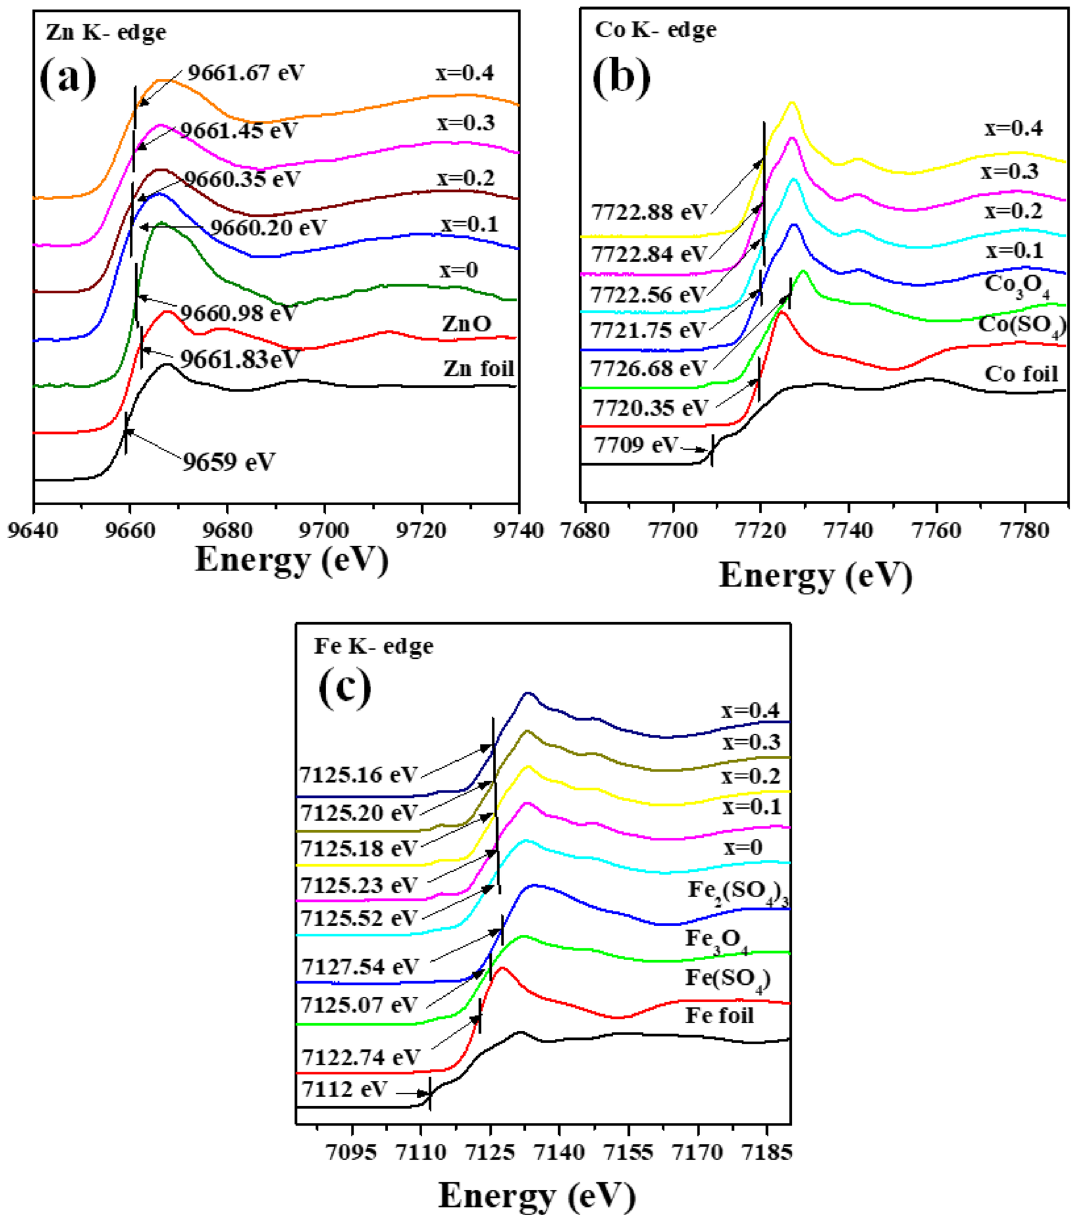
Figure 8. ( a ) Zn, ( b ) Co and ( c ) Fe K-edge XANES spectra of various standard materials and Co x Zn 1−x Fe 2 O 4 (x = 0.0–0.4) resistance (Rct), constant phase element (CPE) and Warburg resistance (Rw), is displayed in the inset of Fig. 12d. The plots shown in Fig. 12d display three regions, depending on the applied frequency 1,7 . Initially, the Z’ axis intercept in the high frequency range represents the solution resistance (Rs) of the 3 M KOH electrolyte and working electrode interface 6,15,38,43 . The Rs value for each Co x Zn 1−x Fe 2 O 4 (x = 0.0, 0.1, 0.2, 0.3 and 0.4) NPs elec- trode was found to be 0.55, 0.67, 0.71, 0.68 and 0.82 Ω, respectively. However, the slight increase of Rs causes a reduction in the conductivity of the KOH electrolyte 6,38 . In the next frequency range, where semicircular loops are observed, the diameter of each semicircular loop is related to electron charge transfer resistance (Rct) at the electrode and electrolyte interface, resulting from the Faradaic redox process 6,38,43,44 . Accordingly, the Rct values were respectively found to be 4.56, 4.46, 3.83, 3.63 and 3.72 Ω for Co x Zn 1−x Fe 2 O 4 (x = 0.0, 0.1, 0.2, 0.3 and 0.4) NPs electrodes. It is clear that the Rct value of the Co 0.3 Zn 0.7 Fe 2 O 4 (x = 0.3) electrode is lower than that of other electrodes, indicating higher electrolytic ion diffusion. This might be due to the homogeneous surface of electrode that could provide area for effective active sites for the OH − ions of the KOH electrolyte, promoting their easy access. This is in good agreement with the lowest Rct value 15,42,43 . Last, in the low frequency range, the observed slope of the straight-line portion of the curve reflects the Warburg resistance (Rw). This represents the ion diffusion process of redox material in the KOH electrolyte 6,38 . The increased slope in this frequency range